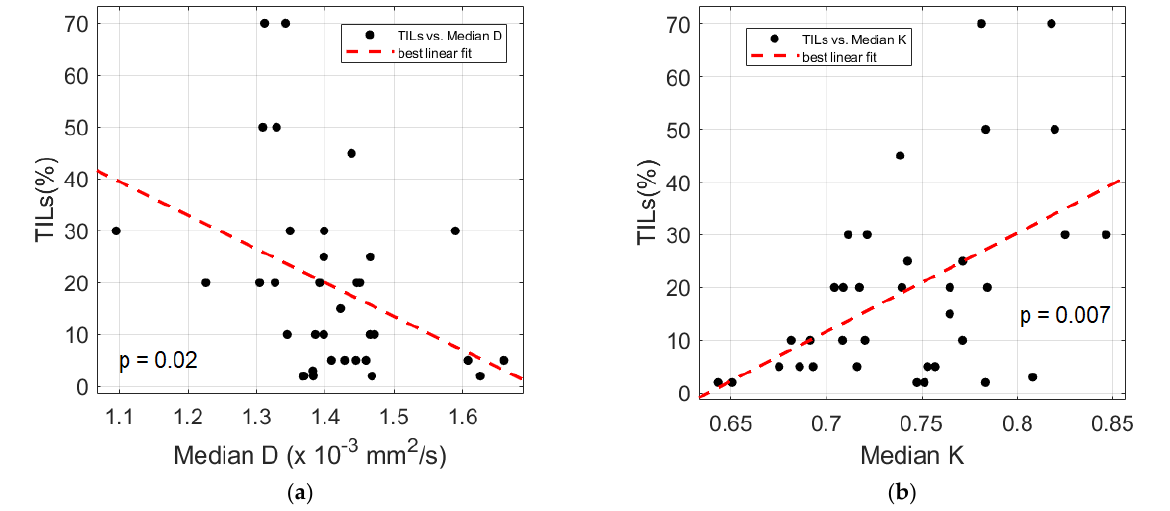
Figure 2. Scatter plots of percentage TILs versus median D ( a ) and median K (unitless) ( b ). The p -values for the Spearman correlation tests are indicated for each plot and the best linear polynomial fit is depicted (dashed red line).